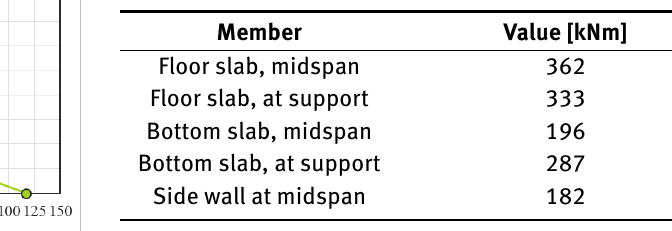
Figure 9: Distribution of bending moments in bridge left and right side walls